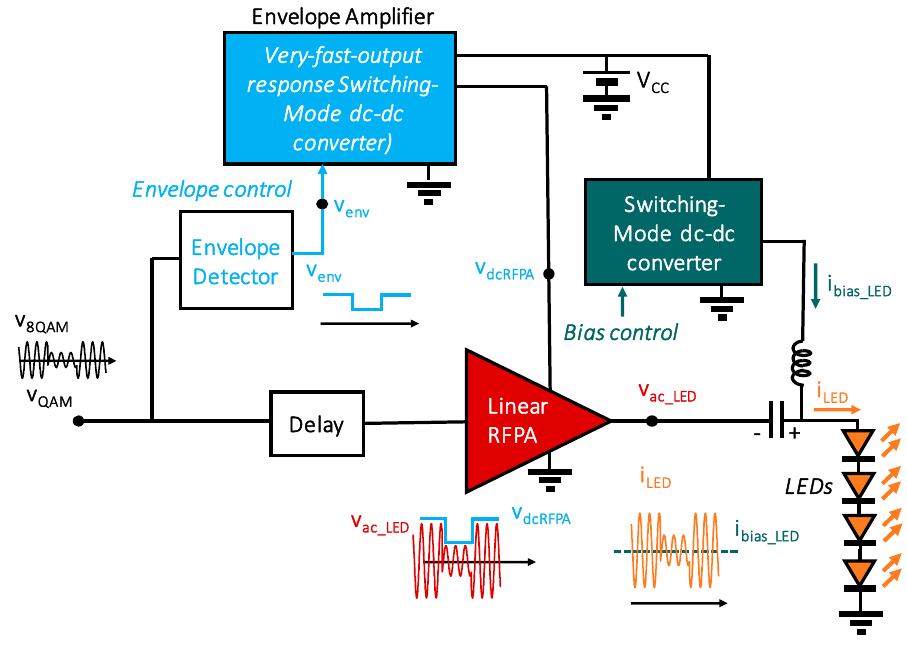
Figure 4. Appling the ET technique to an RFPA of a VLC-LED driver reproducing an MCM scheme (i.e., 8QAM).